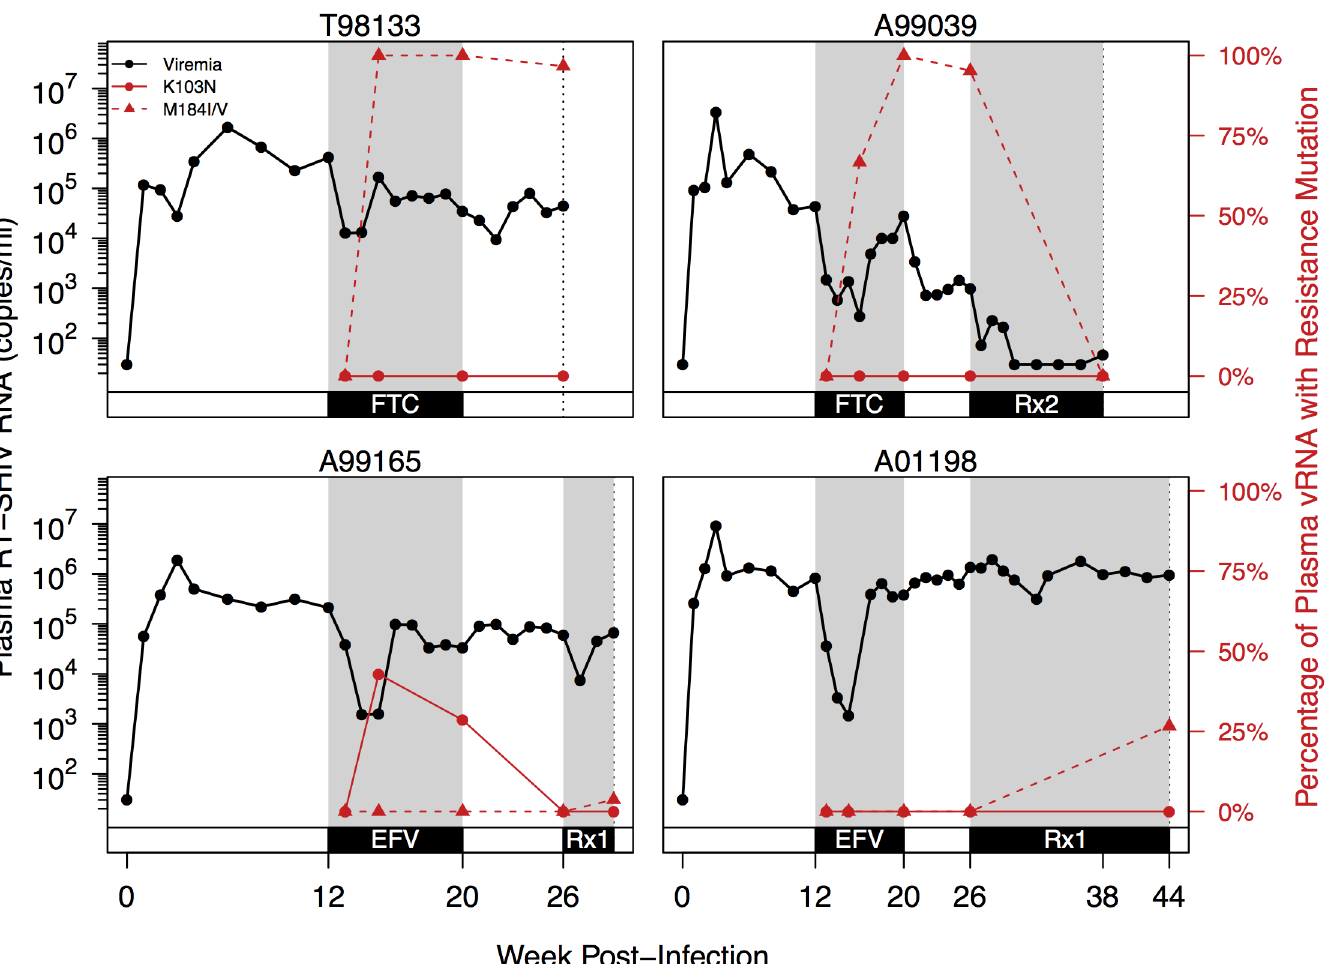
Fig 1. Plasmaviremia and drug resistance in four macaques over the course of infection. Plasma RT-SHIV (black) and frequencyof plasma vRNA with DRMs (red) are plotted over time for each animal,as determined by SGS. Red lines show the frequency of K103N(solid) or M184I/V (dashed) in the plasma vRNA. Gray shadingdenotes administration of drug(s) betweenweeks 12–20 and weeks 26–44.Black dotted line indicates the final time point for each animal.Rx1 is treatment FTC+TFV+EFV and Rx2 is the treatment TFV+L870812+DRV/r.